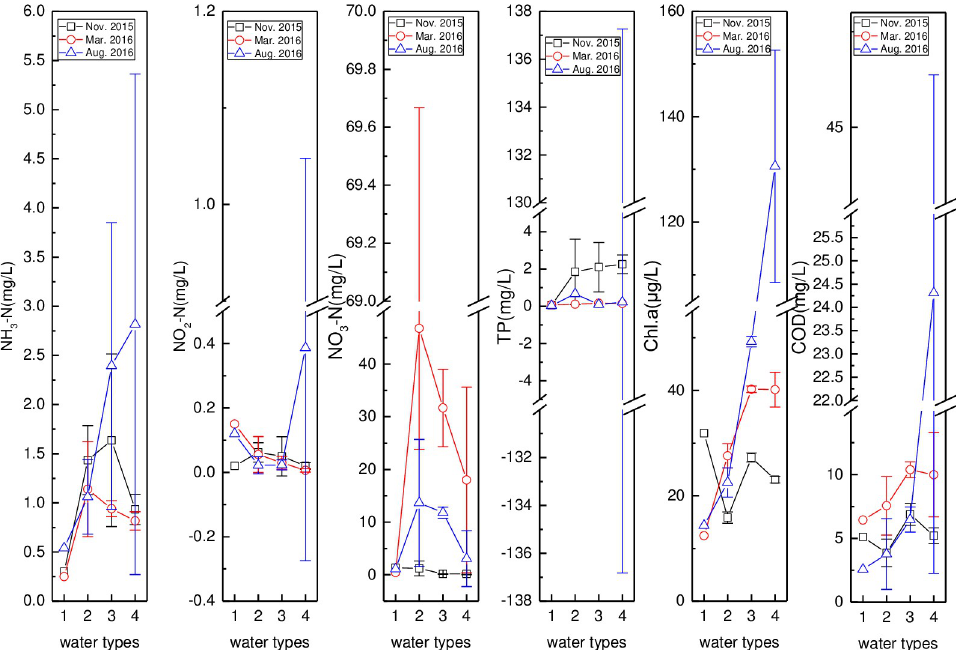
Fig 6. Variation of nitrogen, phosphorus, Chl . a , and COD in Wenjiao River (names of monitoring stations HN15, HN14, HN11, HN10, HN09, HN08, and HN33 are represented by 1–7).